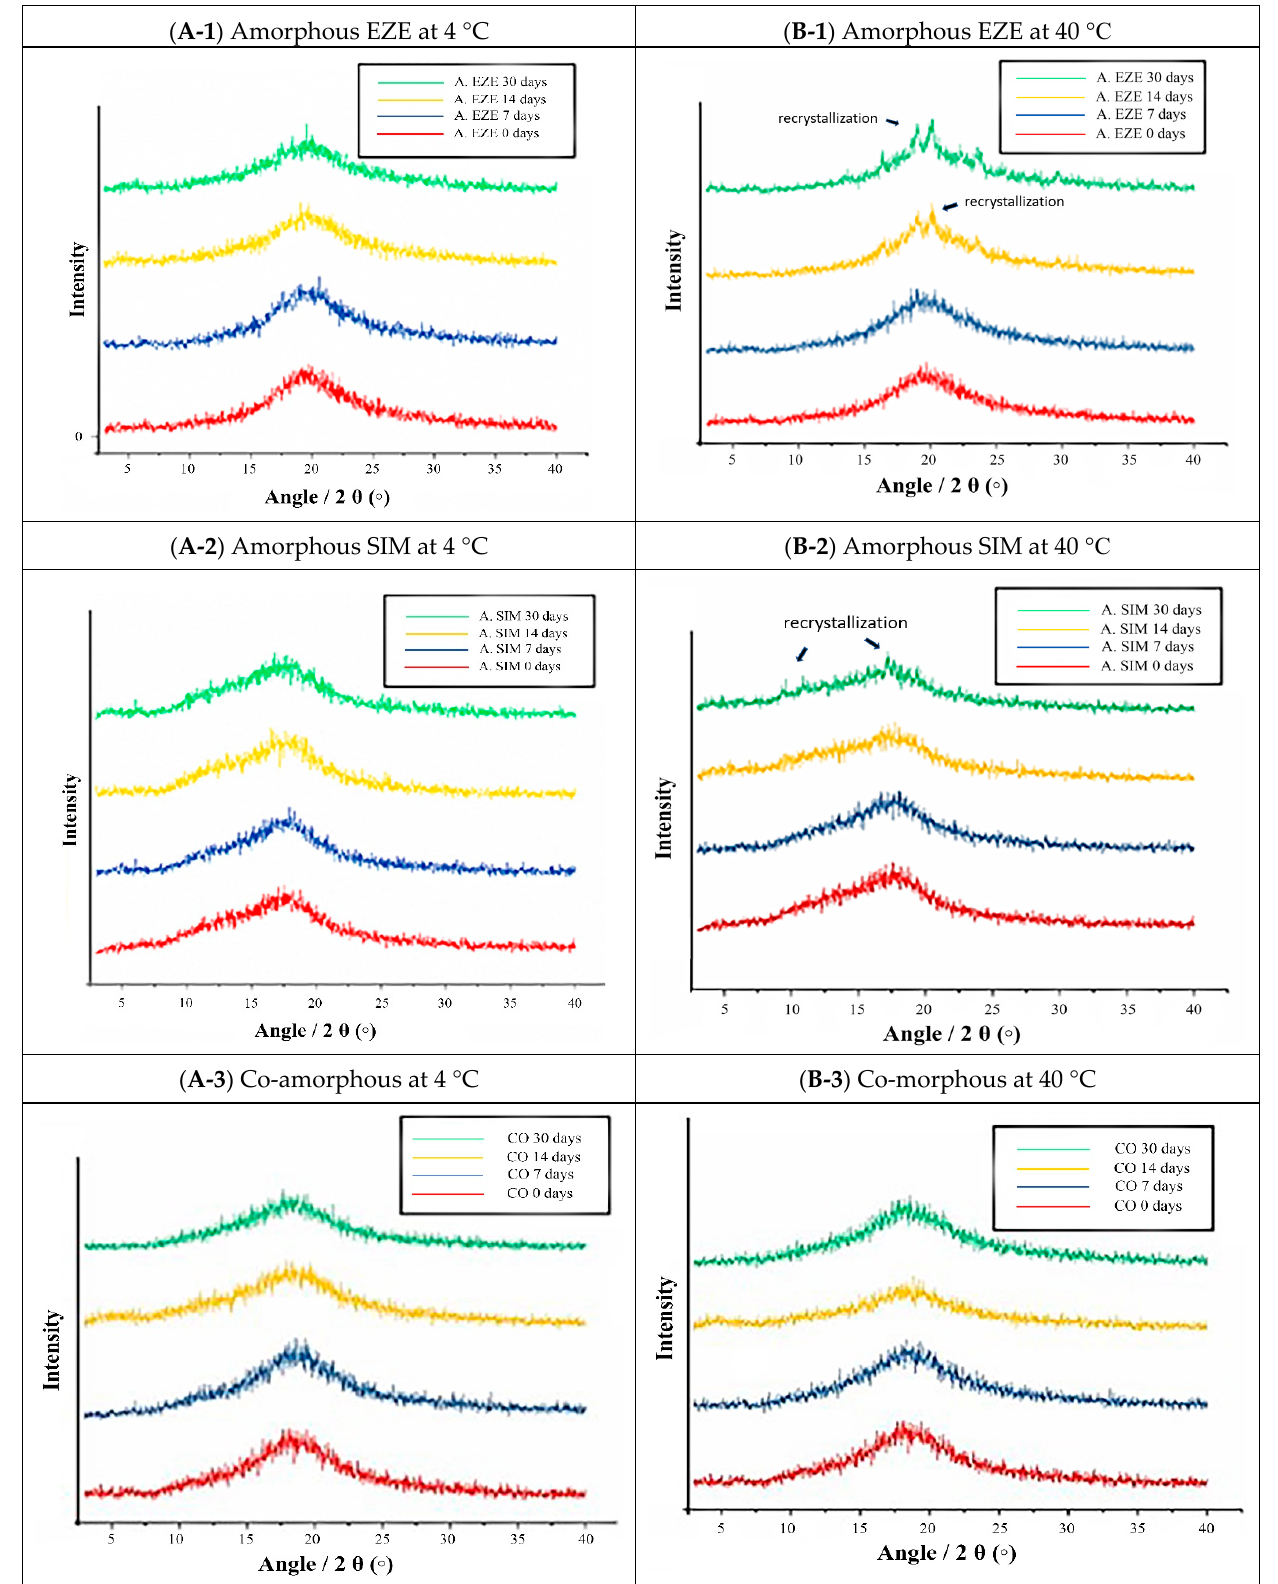
Figure 5. The physical stability of the amorphous EZE (A. EZE), amorphous SIM (A. SIM) and co-amorphous (MQ). ( A ) A. EZE, A. SIM, and CO at 4 °C (left: top to bottom). ( B ) A. EZE, A. SIM, and CO at 40 °C (right: top to bottom).